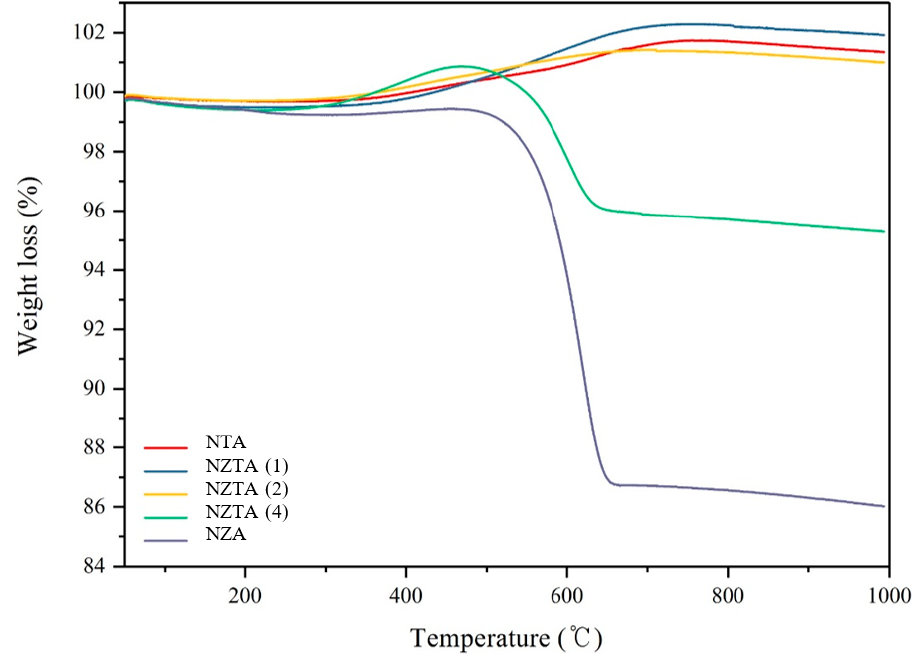
Figure 9. The TGA profiles of the spend catalysts reacted for 5 h.